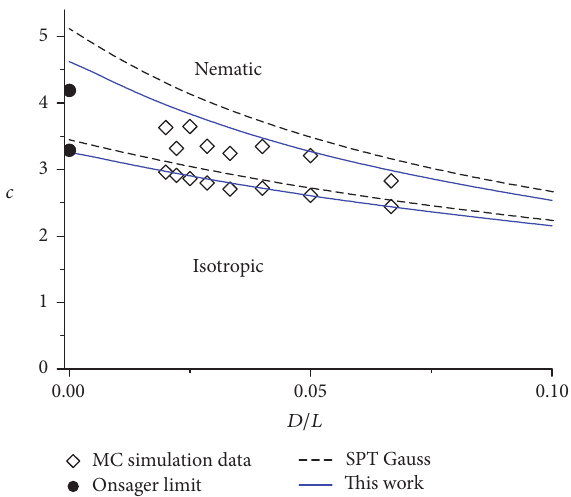
Figure2:Isotropic-nematicphasecoexistenceforhardspherocylin- ders as a function of the inverse of the aspect ratio 𝐿/𝐷 . Scaled particle theory results without (dashed curves) and with (solid curves)correctiontothefreeenergyarecomparedwithMonteCarlo (MC) computer simulation data [17] and the Onsager